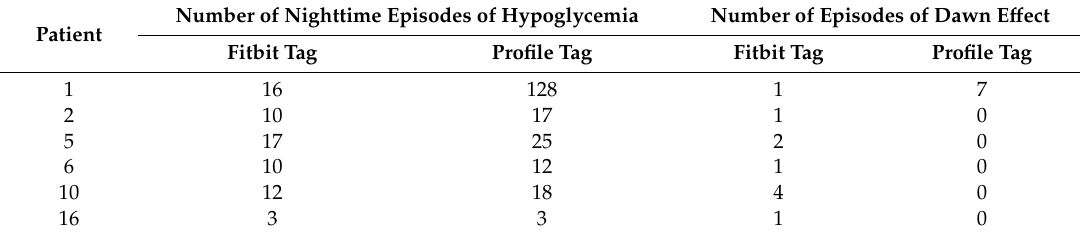
Table 6. Number of nighttime episodes of Hypoglycemia and Dawn E ff ect detected using the profile tag and the Fitbit